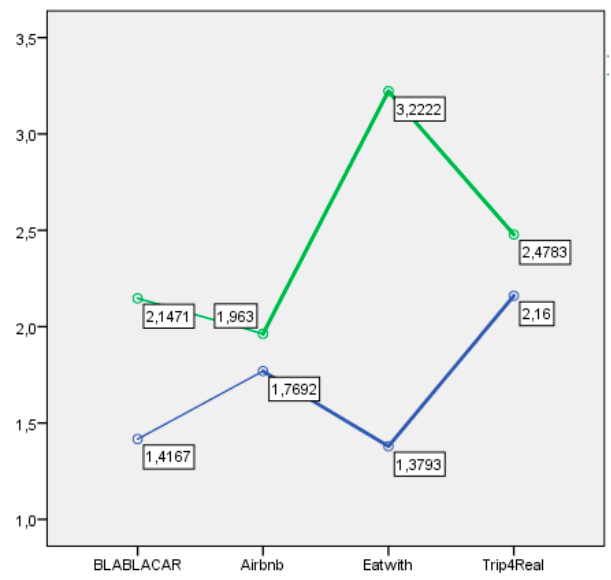
Figure 2. Intention of providing—offering means. Green line: experimental group, Blue line: control group. Table 9. Model with FUT5 “Intention/interest in receiving